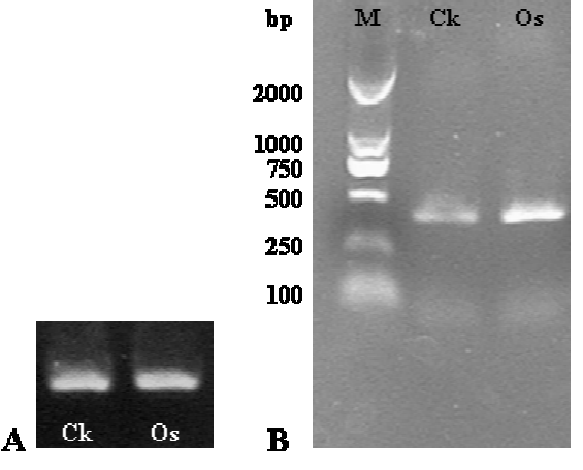
Figure 4. Increase in expression of Chitin in osthol-treated pumpkin. Chitin was amplified by RT-PCR from total RNA derived from osthol-treated pumpkin (Os), with plant treated with water as control. The expected size of the resulting cDNA fragment was 329 bp (B). As an internal control, the actin transcript was also amplified by RT-PCR (A). Sizes of the molecular length standards (M) run in parallel are indicated at the